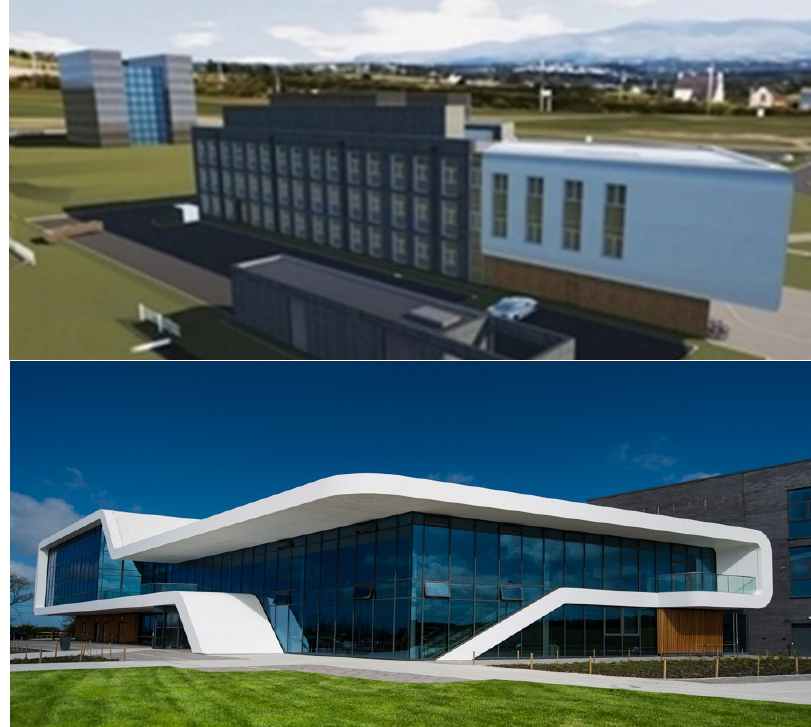
Figure 1: [Upper] Vision of M-SParc from West with NTHF building in